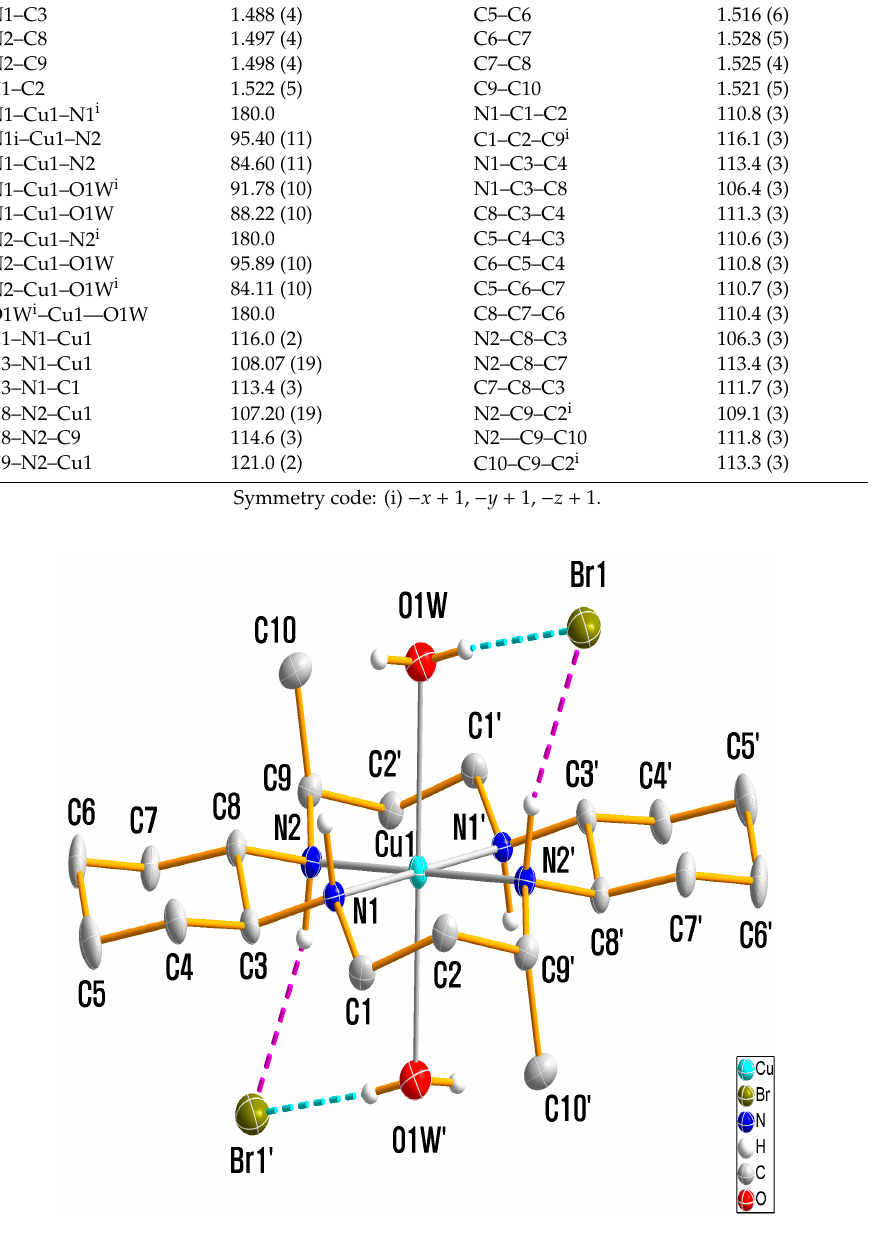
Figure 1. Molecular structure of complex (I).